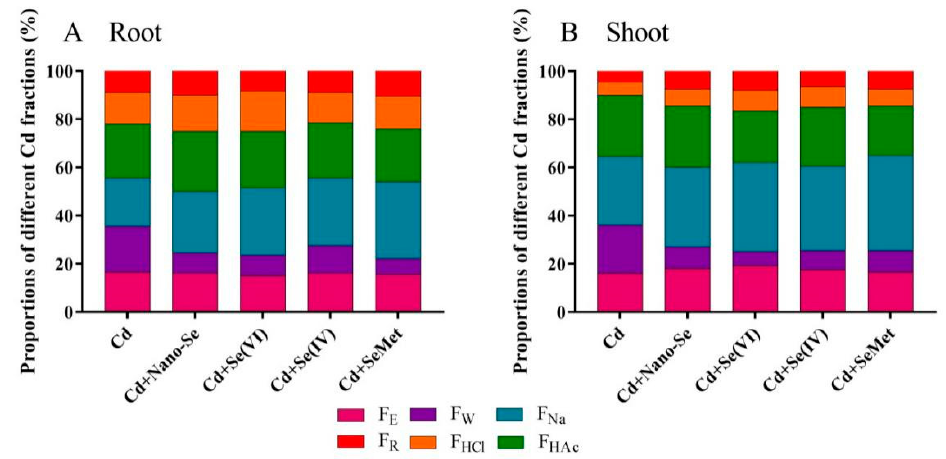
Figure 3. E ff ects of di ff erent Se forms on chemical forms of Cd in the roots ( A ) and shoots ( B ) of rice seedlings in the presence of Cd.